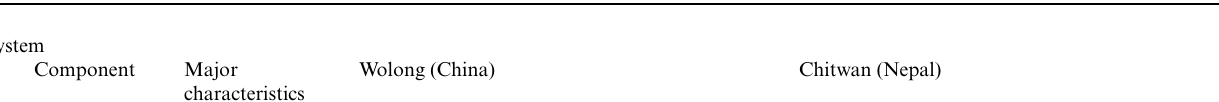
Table 1. Major characteristics of key components in coupled human and natural systems in Wolong, China, and Chitwan, Nepal. We focused on the dynamics of these coupled systems as they pertain specifically to the globally endangered giant panda in Wolong and Bengal tiger in Chitwan. The manner in which disturbances, conservation policies, and feedbacks weaken and/or strengthen human- nature interactions (wildlife impacts on people and vice-versa) in both sites are described in the